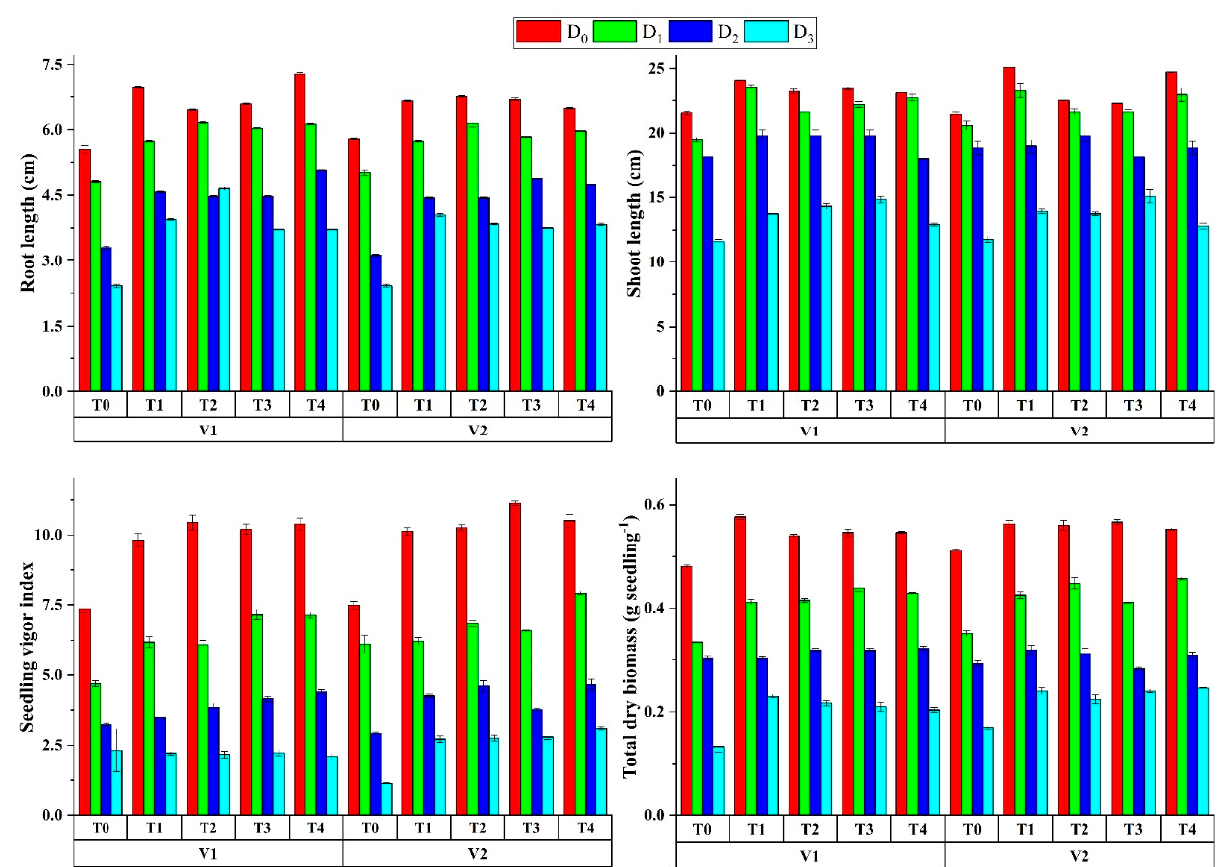
Figure 4. Efficiency of exopolysaccharide-producing, drought-tolerant rhizobacterial strains to improve root length, shoot length, seedling vigor index and total dry biomass; V1: Johar-16; V2: